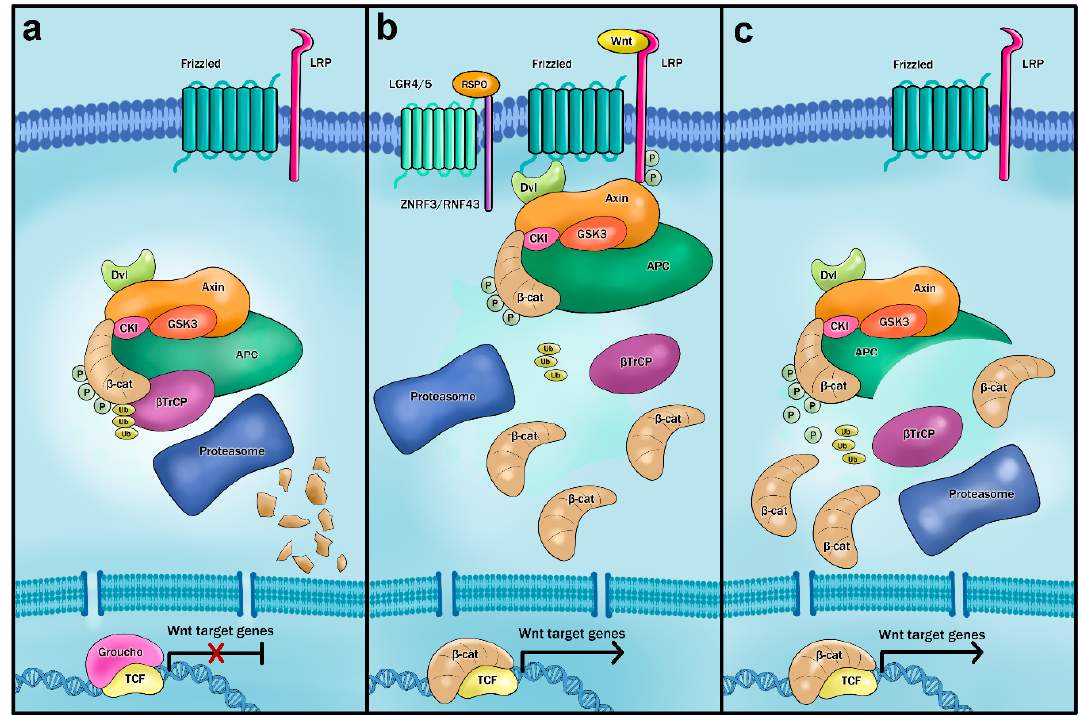
Figure 1. The canonical Wnt signaling pathway. ( a ) In the absence of Wnt ligand, a cytosolic protein complex composed of adenomatous polyposis coli (APC), axis inhibition (Axin), casein kinase 1 α (CK1 α ), glycogen synthase kinase 3 β (GSK3 β ), and β -transducin repeat-containing E3 ubiquitin protein ligase ( β TrCP) mediates phosphorylation and ubiquitination of β -catenin ( β -cat). Phosphorylated β -catenin is subsequently degraded by the proteasome. In such a situation, transcription factors from the T-cell factor / lymphoid enhancer-binding factor (TCF / LEF) family are held in an inactive state by interaction with transcription repressor Groucho that blocks transcription of Wnt signaling target genes. ( b ) Binding of the Wnt ligand to receptor Frizzled and co-receptor low-density lipoprotein receptor-related protein (LRP) leads to LRP phosphorylation that induces Axin recruitment to the cell membrane. As a result, the destruction complex is disassembled and β -catenin translocates to the cell nucleus to activate, in cooperation with TCF / LEF factors, transcription of Wnt target genes. R-spondin (RSPO) ligand binds the leucine-rich repeat-containing G-protein coupled receptor (Lgr) 4 / 5, which results in internalization and subsequent proteasomal degradation of transmembrane E3 ubiquitin ligases zinc and ring finger 3 (ZNRF3) and ring finger 43 (RNF43). The ligases mediate turnover of the Wnt receptor Frizzled and their inhibition enhances Wnt signaling. ( c ) Truncated APC protein does not retain the ability to sca ff old the destruction complex, resulting in β -catenin stabilization and aberrant expression of Wnt target genes, i.e., even without the presence of the Wnt